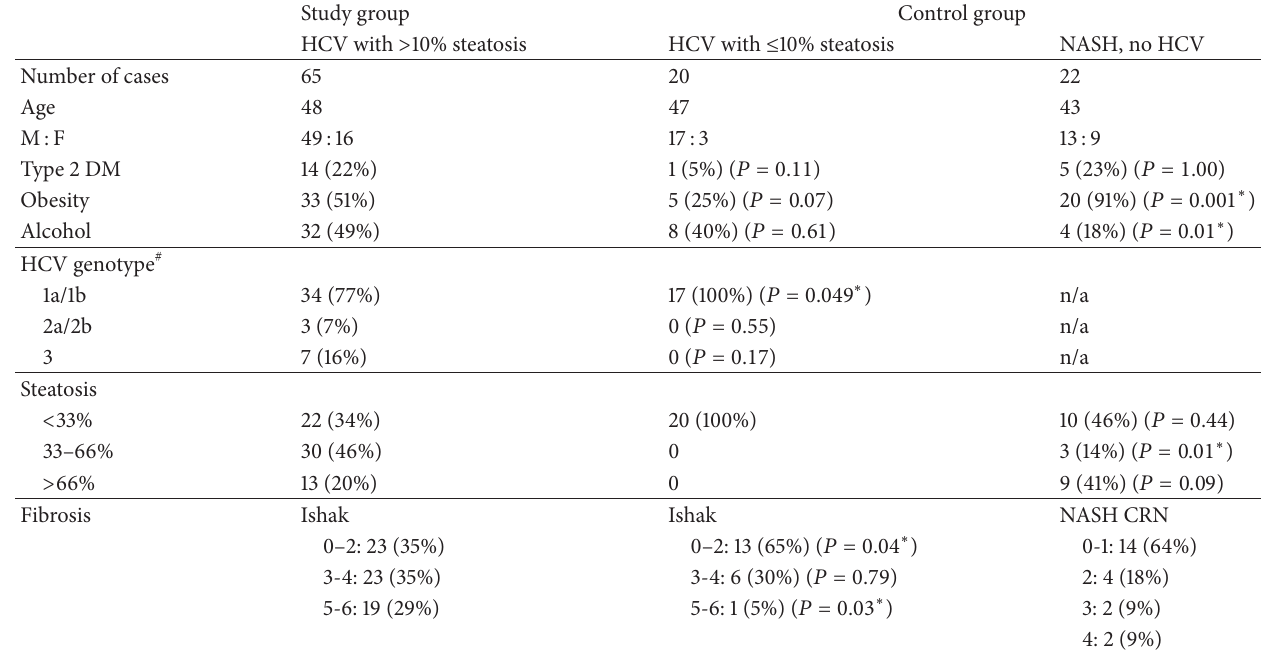
Table 1: Clinical data, steatosis, and fibrosis of steatotic HCV ( > 10% steatosis) study group and two control groups— ∗ 𝑃 < 0.05 by Fisher’s exact test, statistically significant; the information regarding risk factors was unavailable or incomplete in 9 patients of the study group. # HCV genotype was known in 44 cases in the study group and 17 cases in HCV control group. M: male; F: female; DM: diabetes mellitus; obesity: body mass index (BMI) of ≥ 30 kg/m 2 ; n/a: not applicable; Ishak: Ishak’s fibrosis staging system [35]; NASH CRN: NASH Clinical Research Network’s fibrosis staging system for NASH